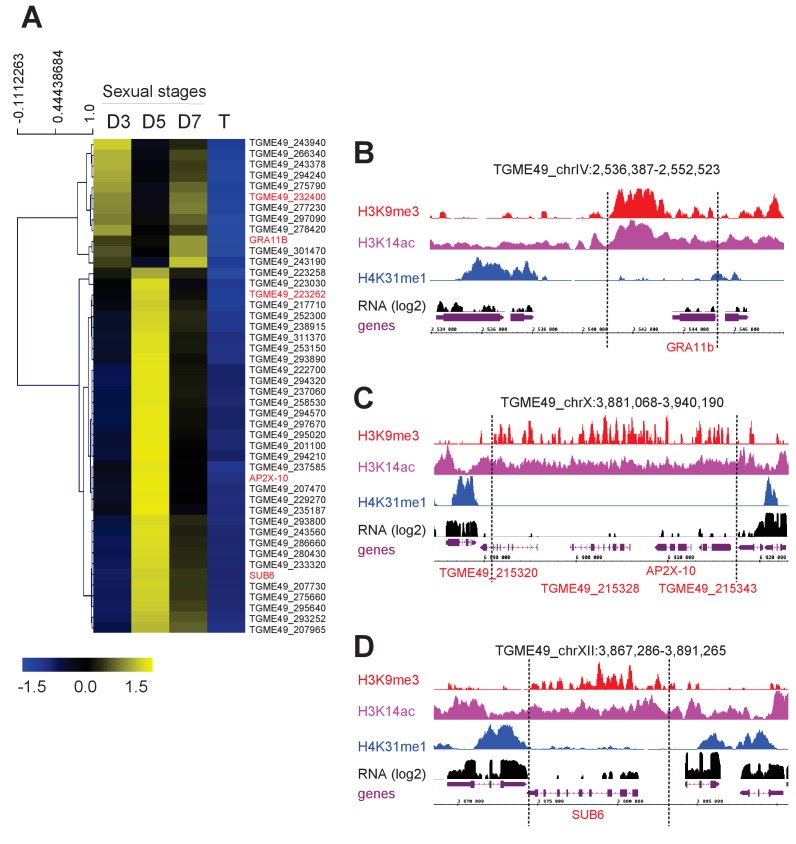
(a) Heatmap representation of T. gondii genes that are specifically expressed in sexual stages as described above. (b–d) IGB screenshots of selected T. gondii genes whose expression is restricted to sexual stages. Reads are shown for various histone marks as well as RNA-seq data (in black) and predicted genes (in magenta). The y-axis depicts read density.